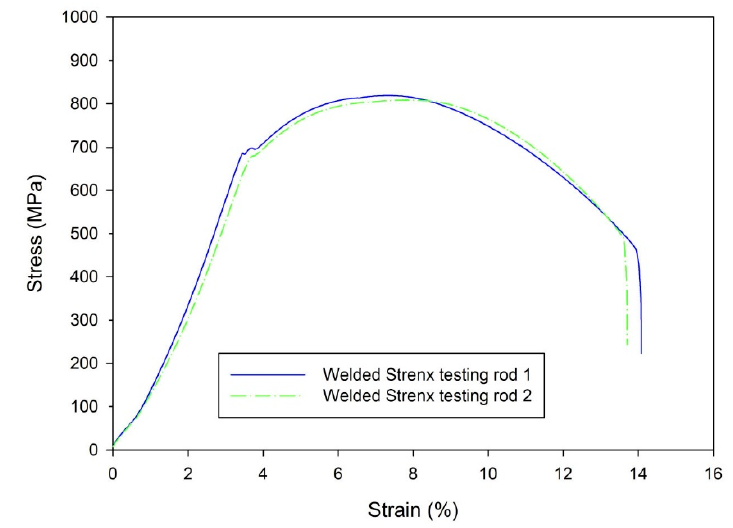
Figure 5. Stress–strain curves of Strenx 700 MC welded joints. Table 4. Results of tensile test, Strenx 700 MC welded joints.